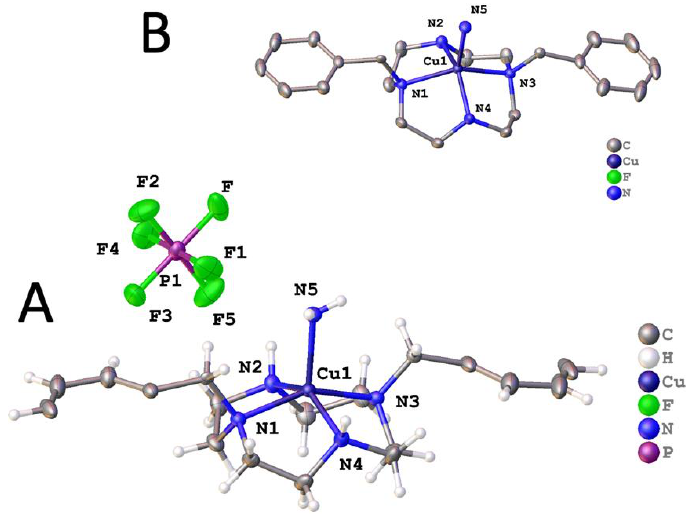
Figure 7. ( A ) Asymmetric unit of [Cu( 1 )(NH 3 )](PF 6 ) 2 with atoms drawn as 50% probability ellipsoids. Other parts of the molecule are generated by the mirror plane. ( B ) Coordination about Cu( 1 ) within the whole molecule. For clarity, hydrogen atoms and disorder are not shown.